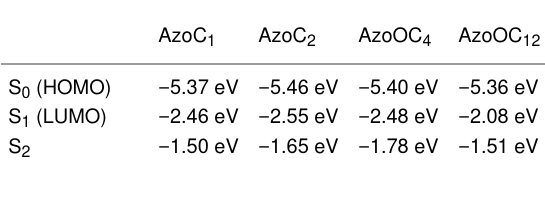
Table 2: Molecular orbitals of the azobenzene ligands determined and calculated using PESA and UV–vis measurements. All spectra can be seen in Supporting Information File 1, Figures